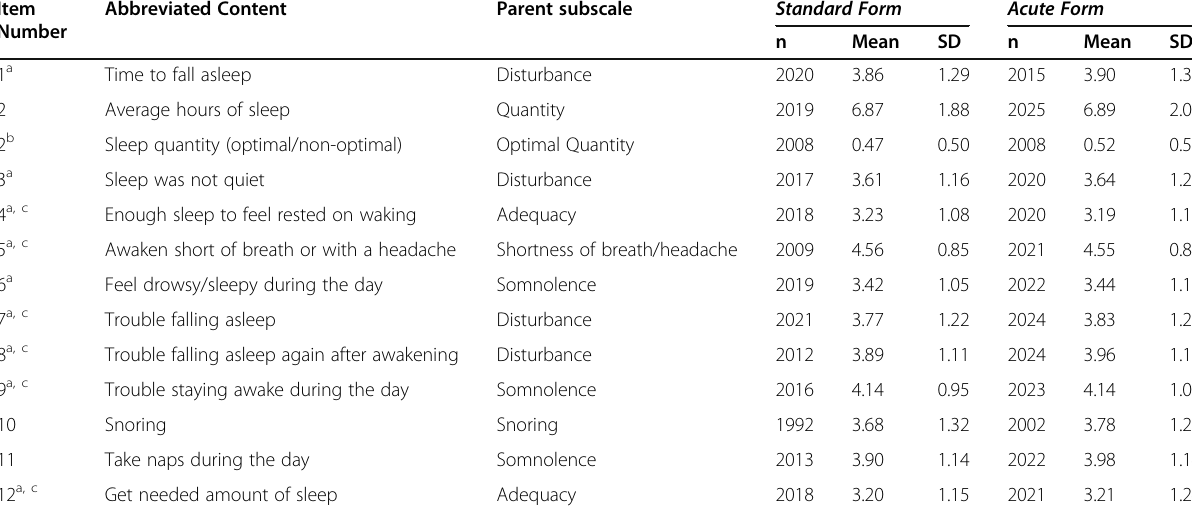
Table 3 MOS Sleep-R standard and acute form item score means and standard deviations